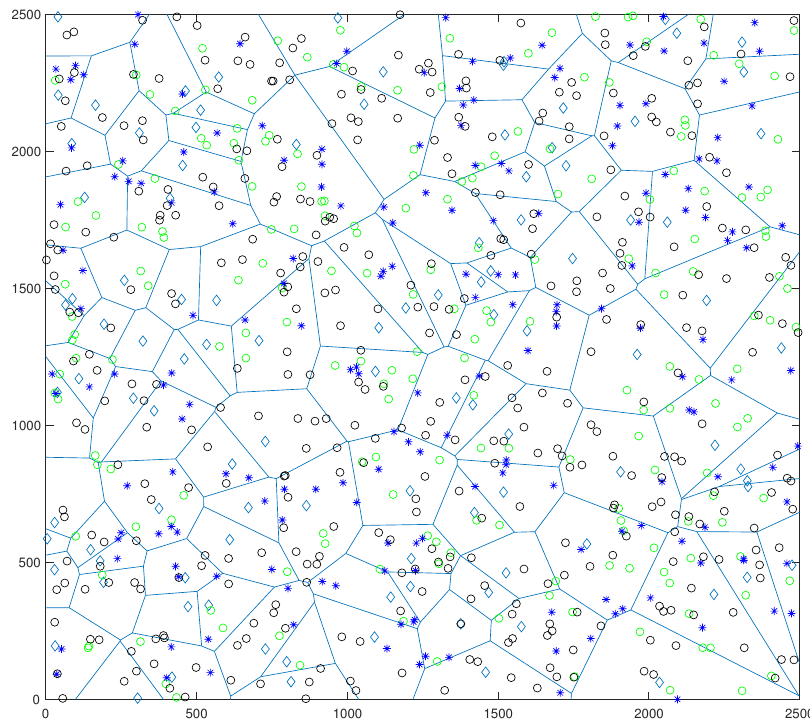
Figure 2. PPP distributions of Nodes. Diamonds represent the eNB, circles represent UEs (green circles are DUEs), and asterisks represent SCeNBs in a cellular